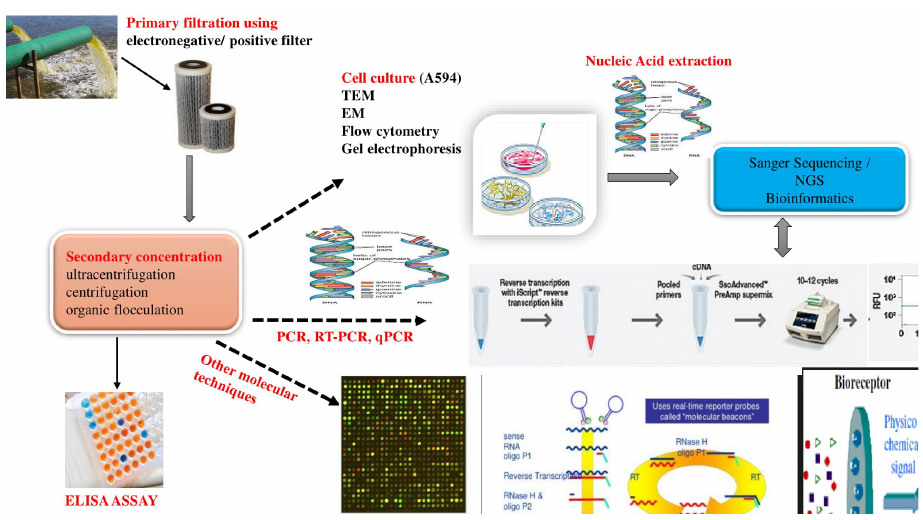
Figure 3. Schematic illustration of various molecular techniques applied for the identification of HEV from different environmental samples.